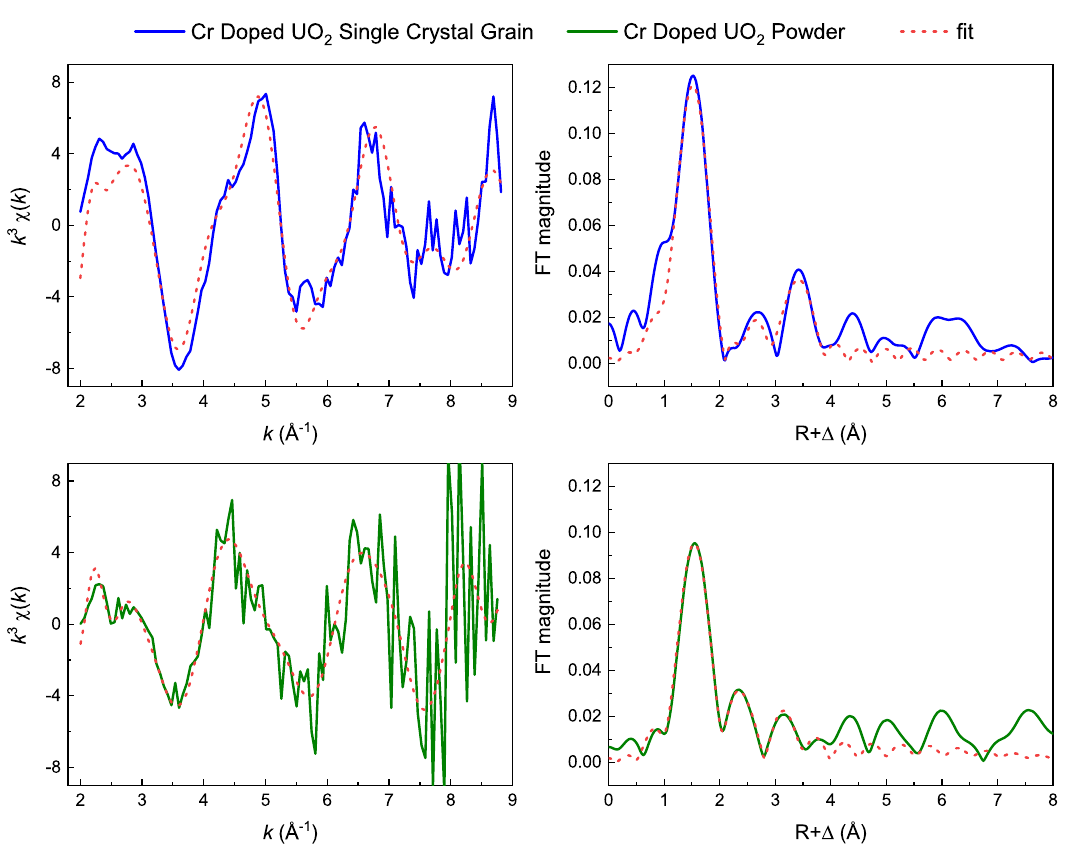
Fig. 3 | EXAFS spectra of Cr-doped UO 2 single crystal grain and bulk material. Fitted k 3 -weighted Cr K-edge EXAFS spectra (left) and corresponding Fourier transforms (FT) in the spectral range from 2.0 to 8.8Å − 1 (right) of the Cr-doped single crystal grain (top) and powder sample (bottom). Phase shifts ( Δ ) are not